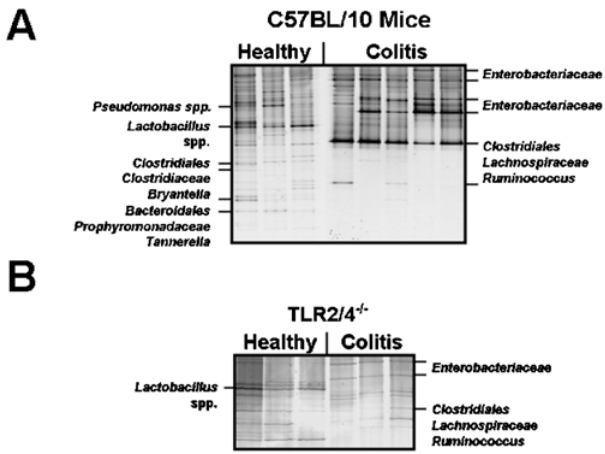
Figure 4. Molecular analysis of predominant bacterial communities in the colon of healthy and diseased mice. ( A ) DGGE profiles of the colon flora in healthy and diseased wt mice. Results are shown for C57BL/10 wt mice without DSS-treatment or at day eight after DSS-treatment for seven days (as indicated above the lanes). Bacterial species were identified by comparative sequence analyses of 16S rRNA gene fragments amplified from DNA eluted from respective DNA bands. The DGGE profiles are representative for at least three mice per group and experiment. ( B ) DGGE profiles of the colon flora in healthy and diseased TLR2/4 -/- mice. DGGE profiles of luminal intestinal bacteria from wt and TLR2/4 -/- mice were generated by PCR-based analysis of total DNA from colon contents of mice with or without colitis at day eight after DSS- treatment for seven days (as indicated). Bacterial species were identified by comparative sequence analysis of 16S rRNA gene fragments amplified from DNA eluted from respective DNA bands. The DGGE profiles are representative for at least three mice per group and experiment. ( A/B ) Primers GC968F and R1378 (Heimesaat et al., 2006) were used for amplification. Results were reproduced in at least two independent experiments.